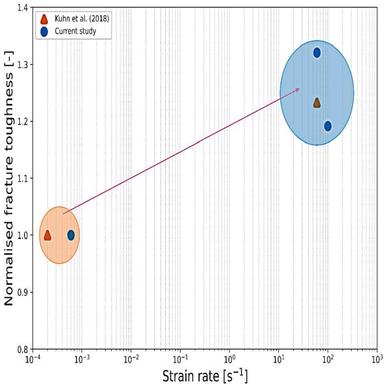
Comparison of the normalised steady-state mode I intralaminar fracture toughness of IM7/8552 measured at different loading rates from quasi-static to strain rates up to 100 s − 1 .